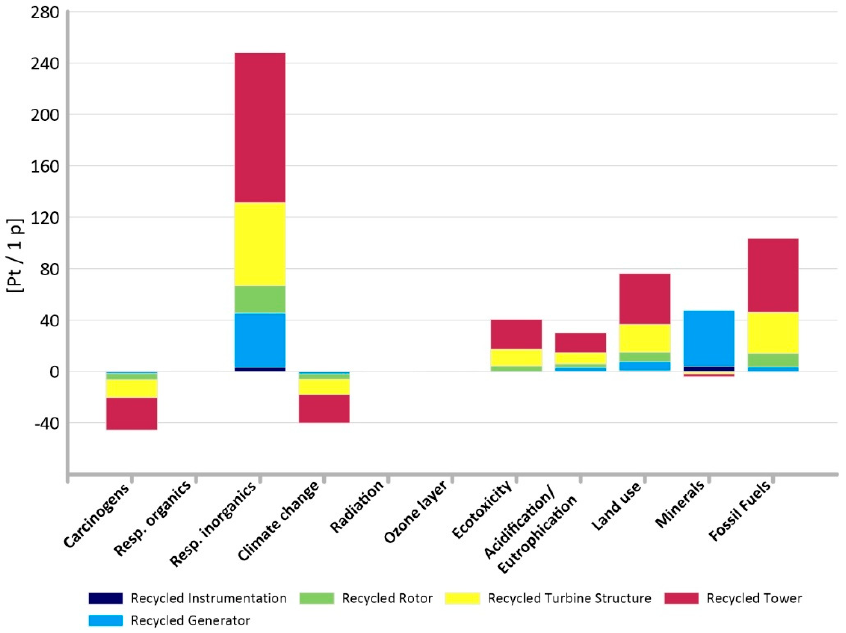
Figure 6. Comparison of results of grouping and weighting of particular impact categories for elements of an innovative power plant—methods with recycling.